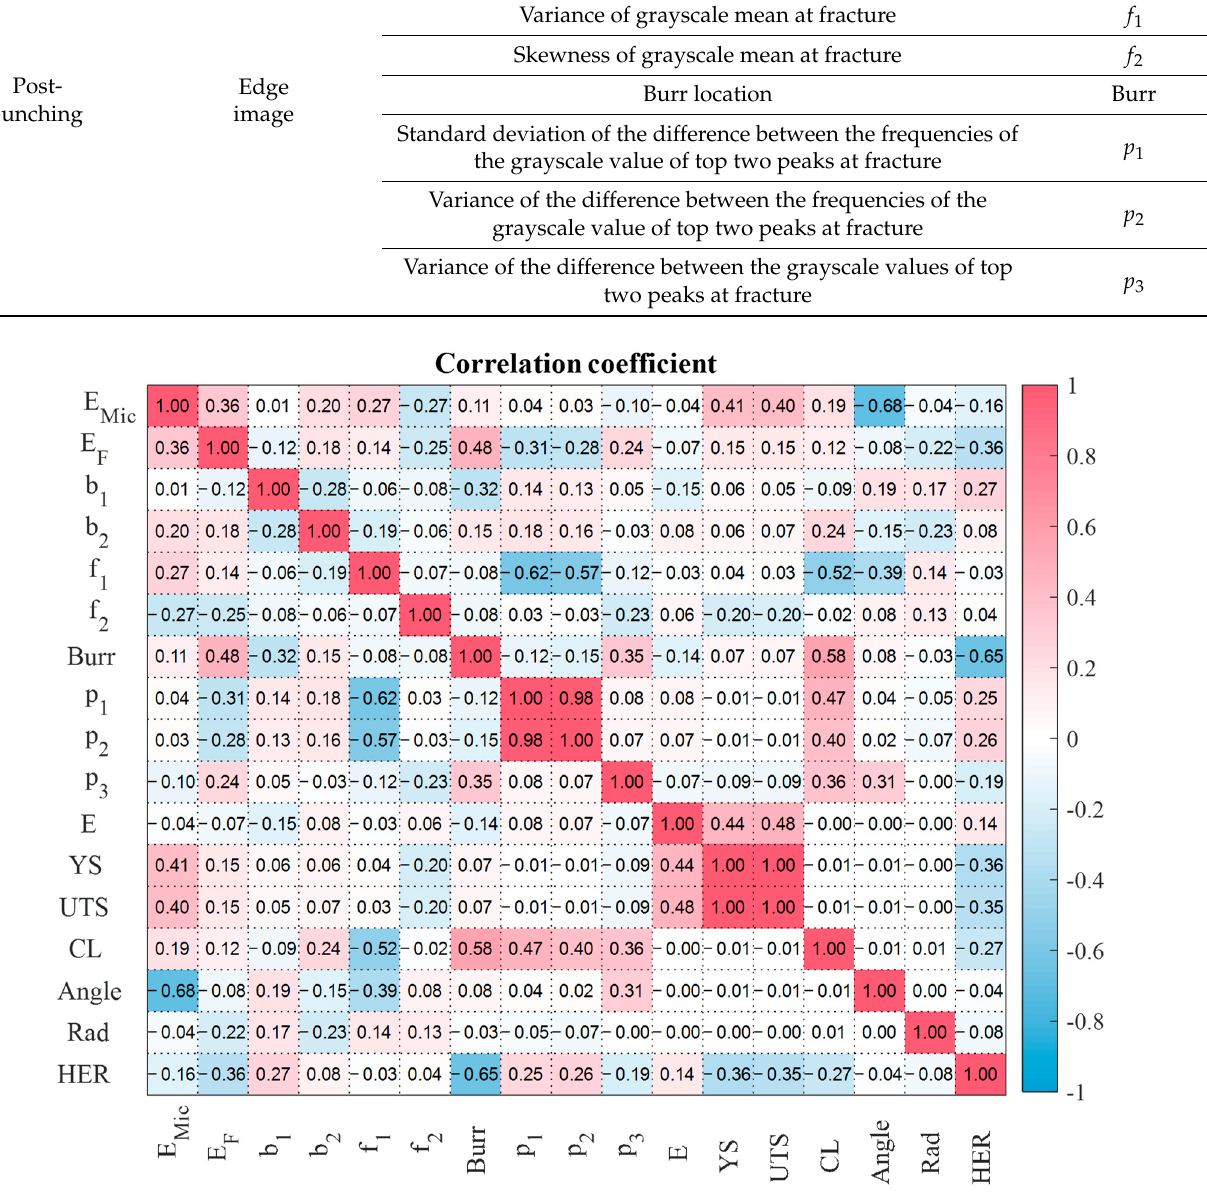
Figure 14. Correlation coefficient between optimized features and